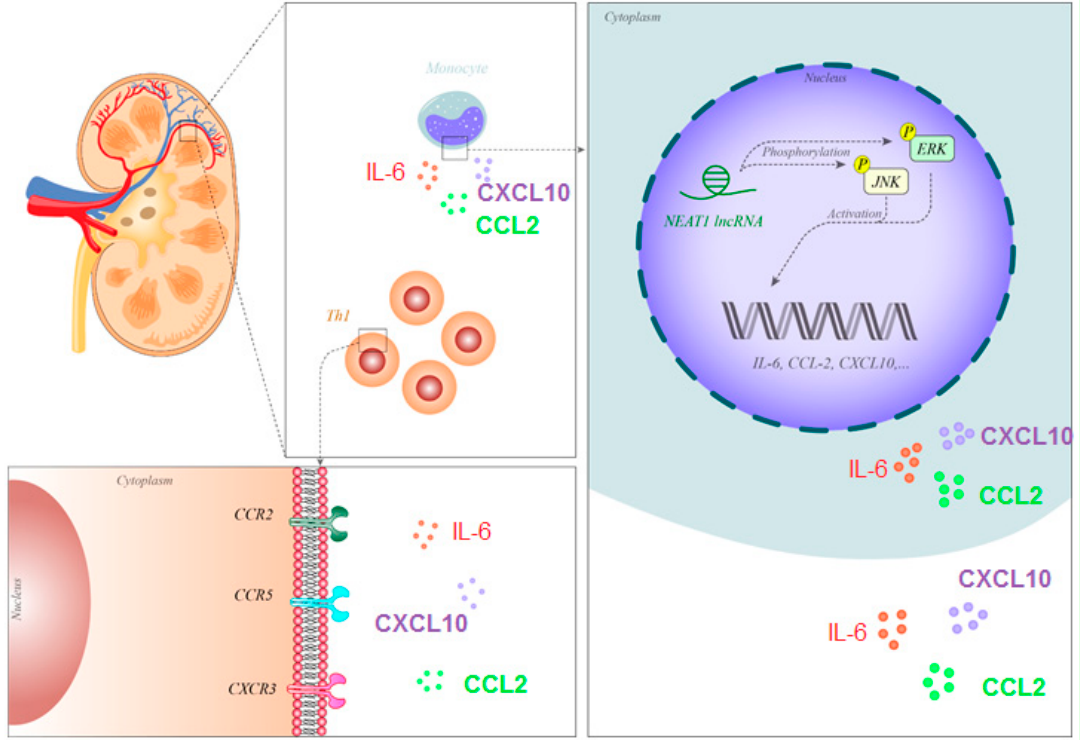
Figure 1. NEAT1 has been shown to be over-expressed in the monocytes of SLE patients. This lncRNA phosphorylates JNK and ERK, thus activating these proteins and enhancing the expression of IL-6, CCL2 and CXCL10. These cytokines/chemokines attract Th1 cells, thus participating in the pathogenesis of nephritis [22]. Abbreviations: SLE, systemic lupus erythematosus; lncRNA, long non-coding RNA, Il-6: interleukin-6, CCL2: C-C motif ligand 2, CXCL10: C-X-C motif chemokine 10.